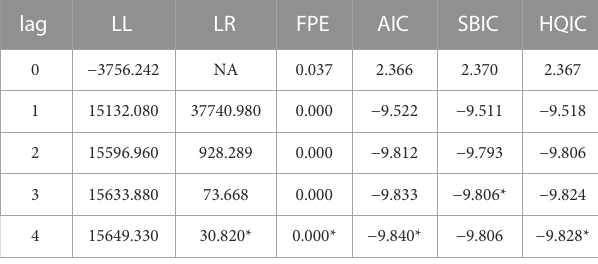
TABLE 3 Results of the gr35 and go5 lagged order